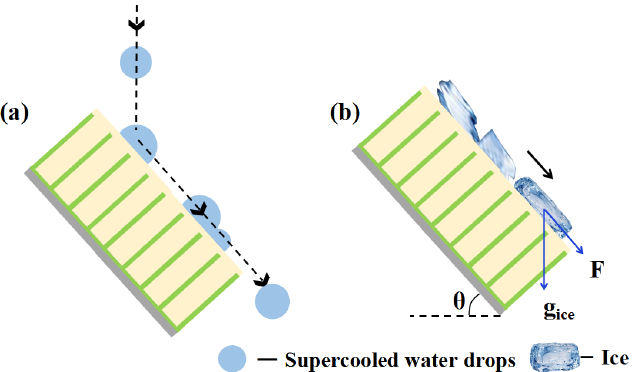
Figure 10. Schematic diagram of the anti-icing mechanism of the SLIPS ( a ) before icing and ( b ) after icing.